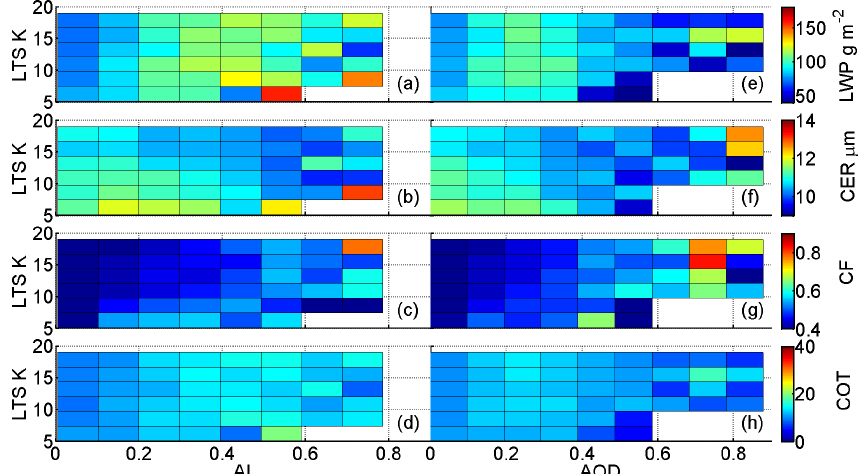
Figure 7. Mean low-level liquid cloud properties plotted as a function of LTS and AI (a–d) or AOD (e–h) .